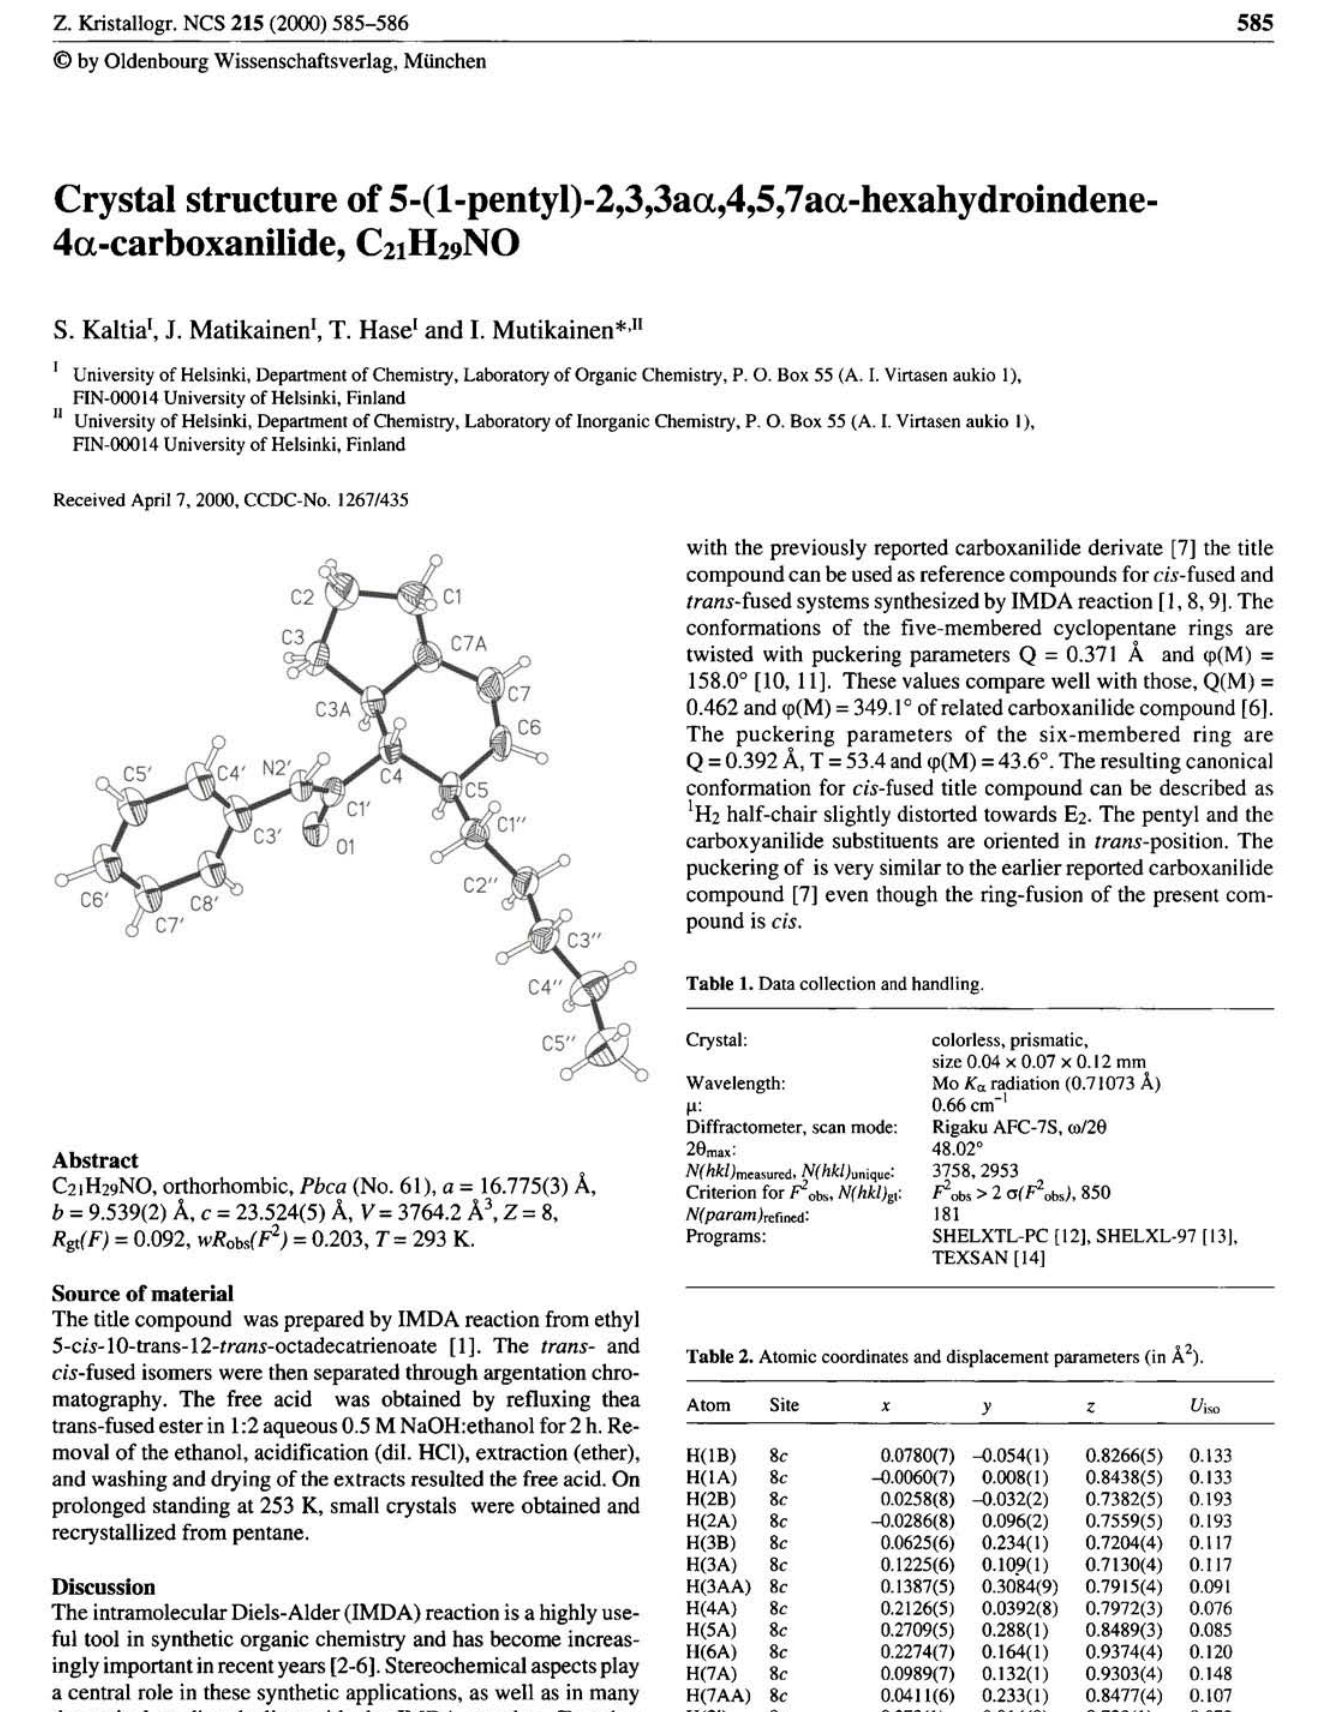
Table 2. Atomic coordinates and displacement parameters (in Â 2